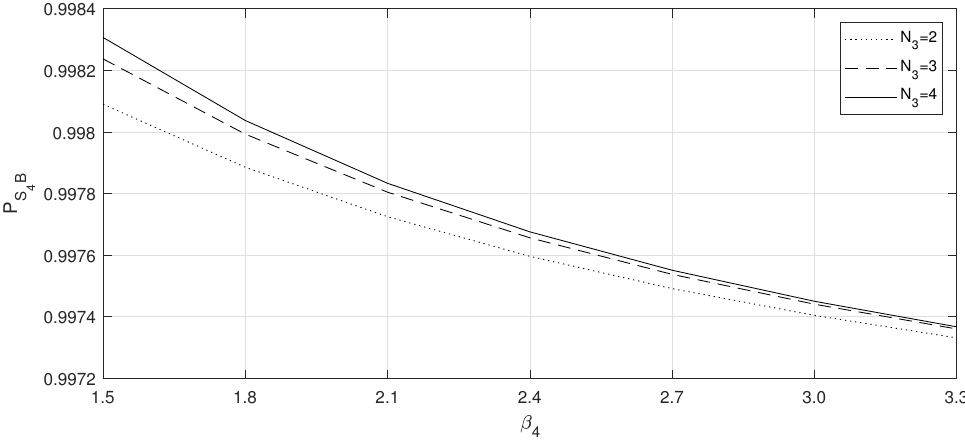
Figure 14. Probability that Server-4 is busy on β 4 vs. N 3